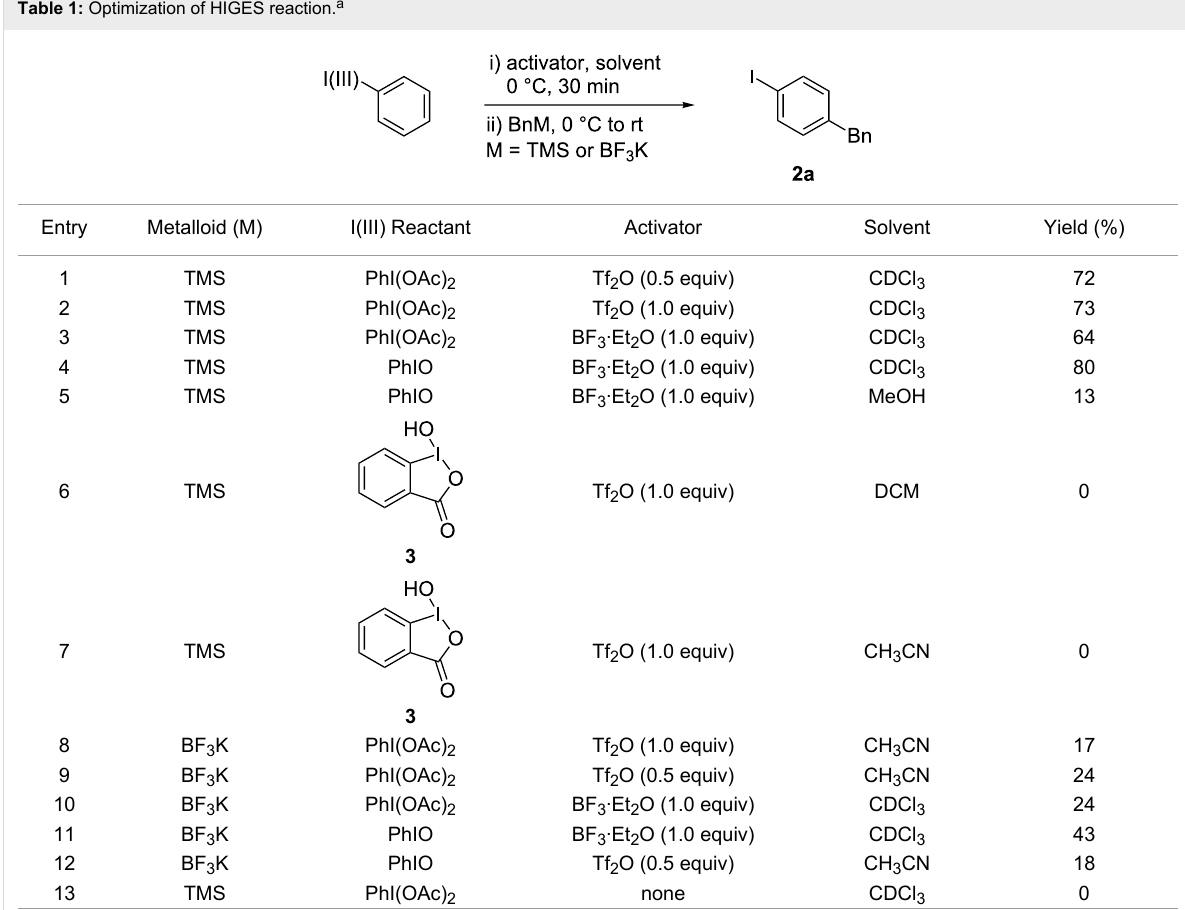
Table 1: Optimization of HIGES reaction.